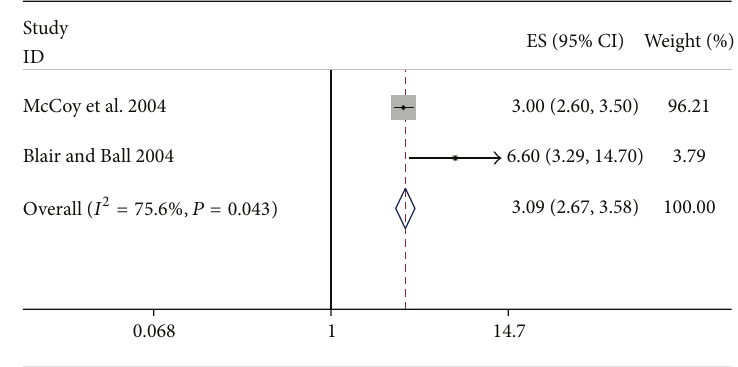
Figure 2: Forest plot: bed share and breastfeeding.